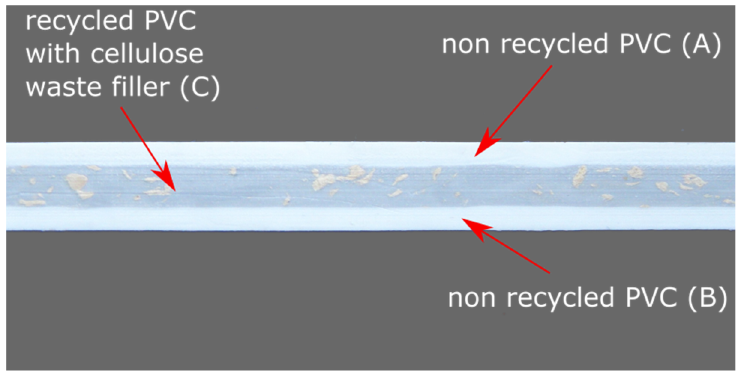
Figure 4. Cross-section of multi-layer material with inner recycled PVC with cellulose filler (C) and non-recycled PVC outside layers (A,B).